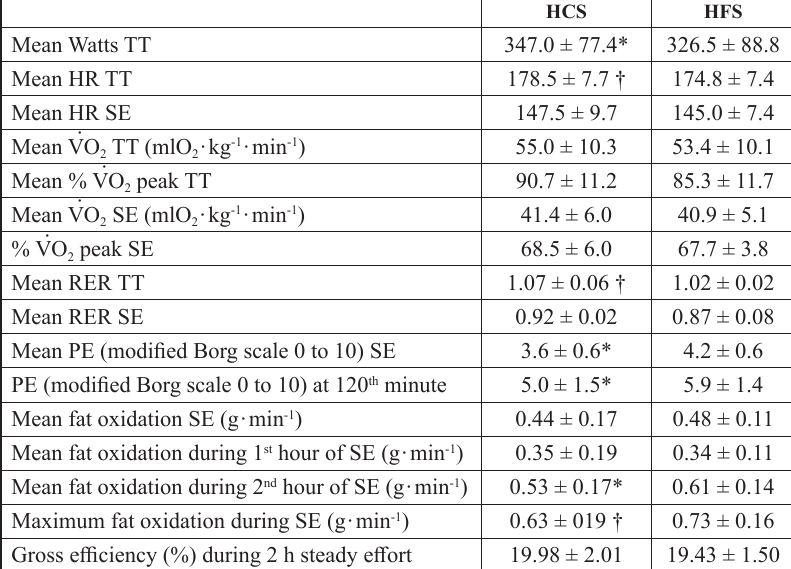
Table 3. Power, perceived exertion ratings, metabolic values and gross efficiency during cycling effort